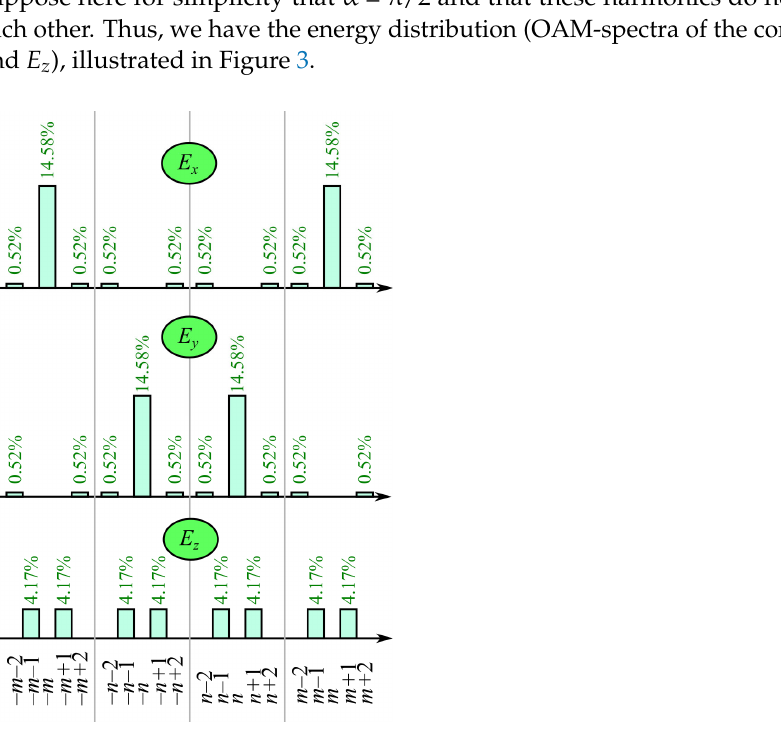
Figure 3. Energy distribution of a tightly focused light field with double-index polarization singularity by the field components and by the angular harmonics. Numbers above each pillar indicate the fraction of the whole energy of the focused light field that goes to the given angular harmonic of the given field component (the sum of all numbers is 100%). As seen in Figure 3, side angular harmonics of the orders m ± 2 and n ± 2 have rela ‐ tively low energy (28 times lower than that of the orders m and n ), and this energy be ‐ comes even lower when the aperture angle starts to decrease from α = π /2.